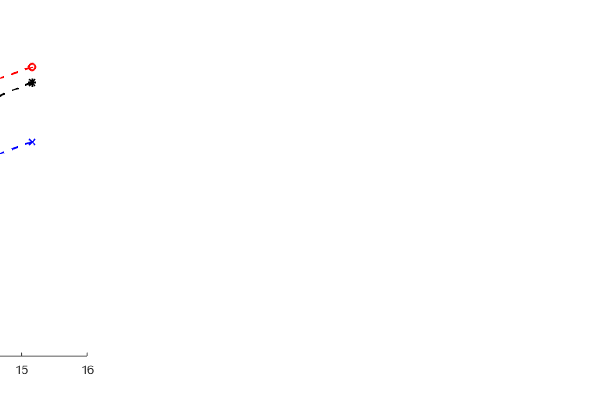
Figure 10. Color image corrupted by salt and pepper noise: performance analysis of three denoising methods.